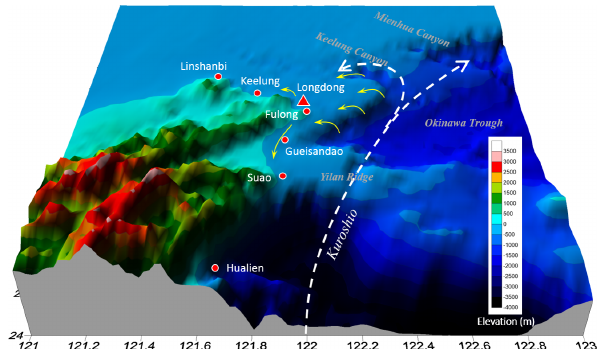
Figure 10. The suggested movement path of cold water. The cold water was pumped from the Kuroshio subsurface in the Okinawa Trough and reached the Longdong coastal waters first. Then, the cold water was transported north to Keelung and south to